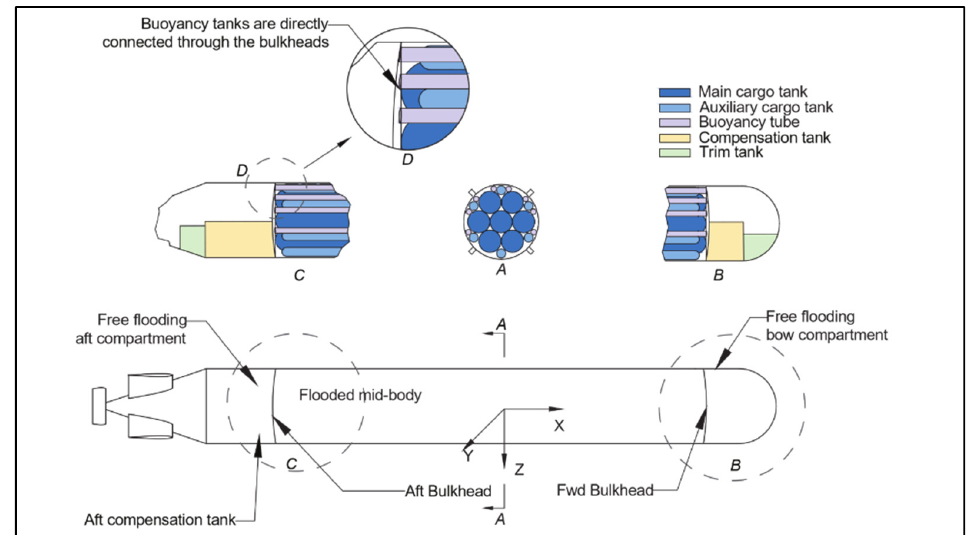
Figure 5. SST general arrangement. A, B, C, and D are the cut-through sections. The SST external hull consists of three compartments: (i) a free flooding aft compartment, which holds moisture-sensitive equipment (gearbox, motor, battery, aft trim tank, aft compensation tank, and rudder controls); (ii) a free flooding bow compartment which holds sonar, radio, sensors, control station, forward compensation and trim tanks, and pumps for offloading; and (iii) a flooded mid-body in the middle, which is the largest